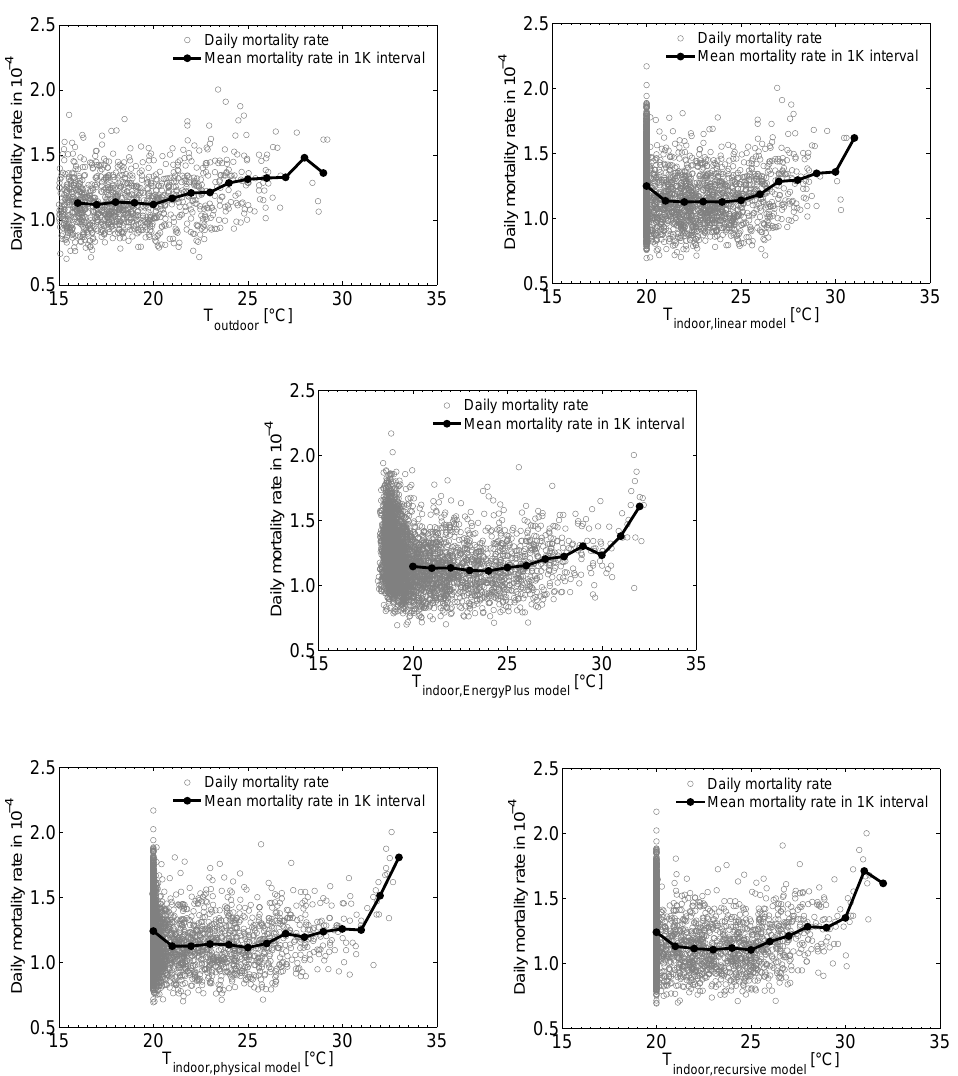
Figure 5. Mortality rate of Berlin citizens aged 65 and older in relation to measured outdoor air temperature, operative room temperature simulated with a complex building model (EnergyPlus), linear building model, physical building model, and recursive building